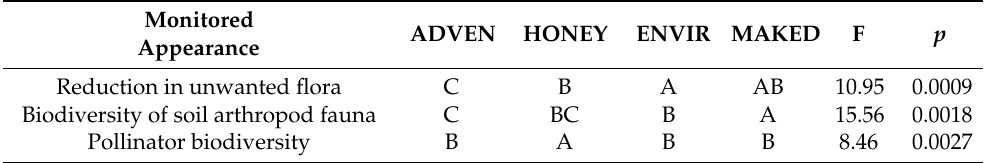
Table 6. Qualitative Summary of the most important aspects of the MFM. Different letters (A, B, C) show significant differences in the analysis of variance obtained through the LSD test ( p ≤